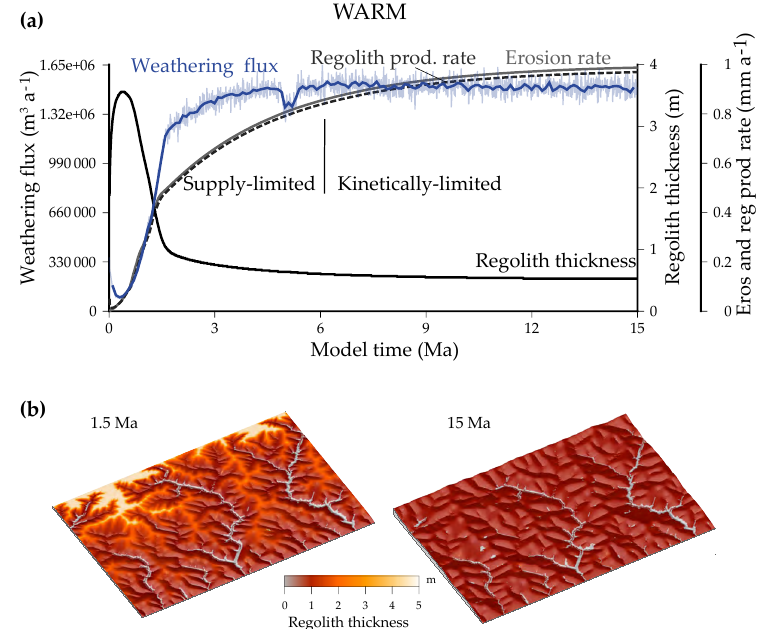
Figure 3. (a) Topography, regolith thickness, erosion, and weathering flux evolutions averaged over the domain in the reference experiment WARM. The thick weathering curve corresponds to a 0.1Myr sliding window averaging. Variations in the weathering curve are mainly due to the stochastic transport of clasts. More clasts decrease this variability but do not change the mean values. The decrease near 5Ma is due to a local hillslope collapse (Eq. 5). Weathering becomes kinetically limited after ∼ 6Ma when the erosion rate is too rapid to allow clasts to stay in the regolith for a long time (low Damköhler number N clast = 0.003). (b) Topography and regolith thickness at 1.5 and